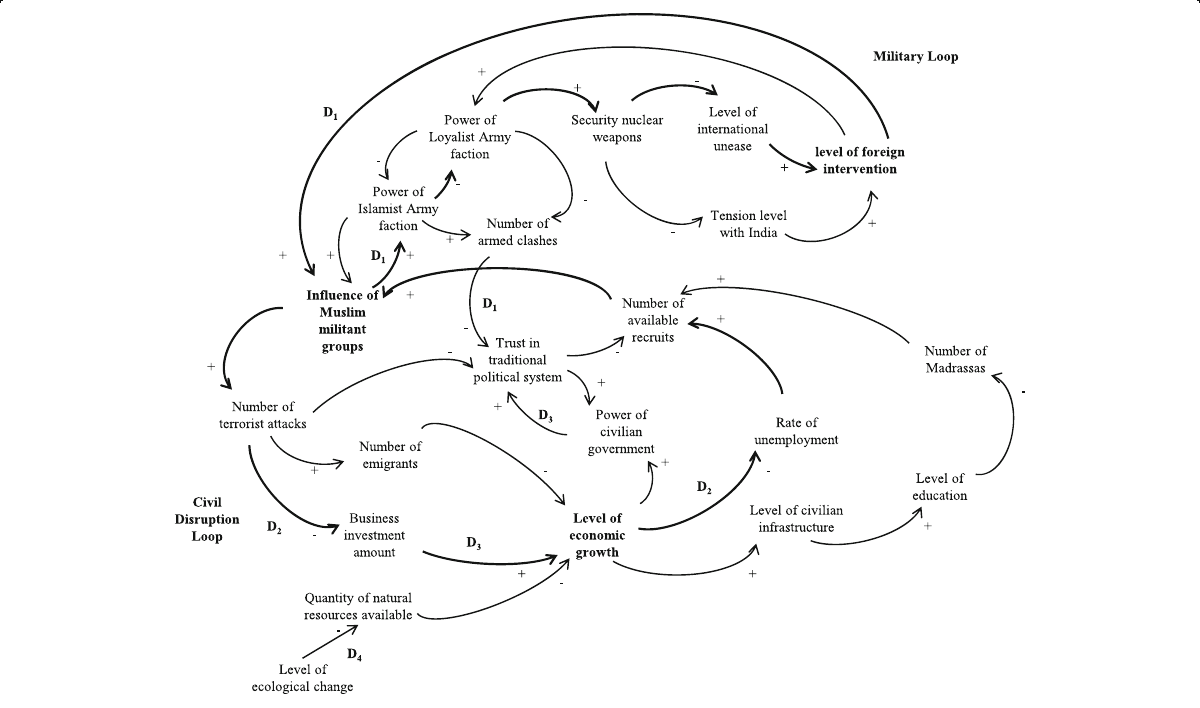
Fig. 2 Influence diagram showing significant loops and changes in the system over time